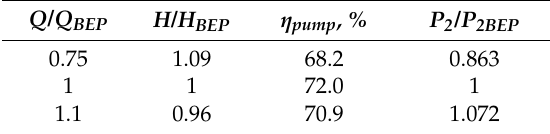
Table 1. Specifications of the 1.1 kW NM 40/12F/A Pump at the rated speed of 2900 rpm.